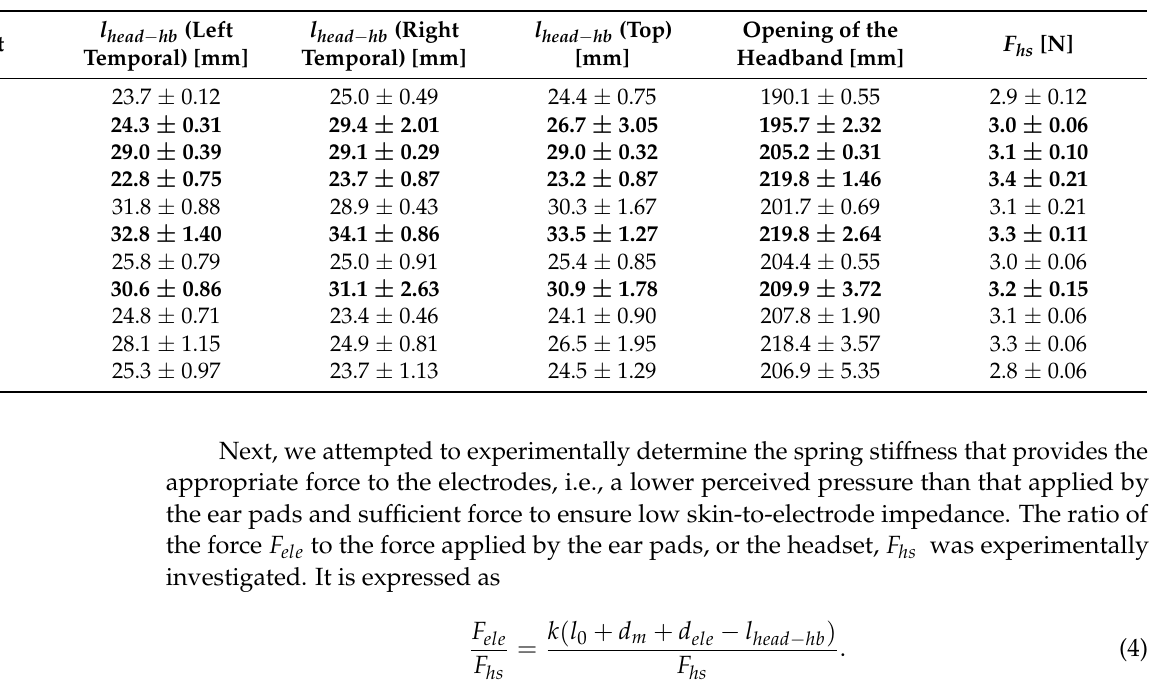
Table 2. Conditions when participants wore headset. Participants B, C, D, F, and H participated in the following experiments (bold in the